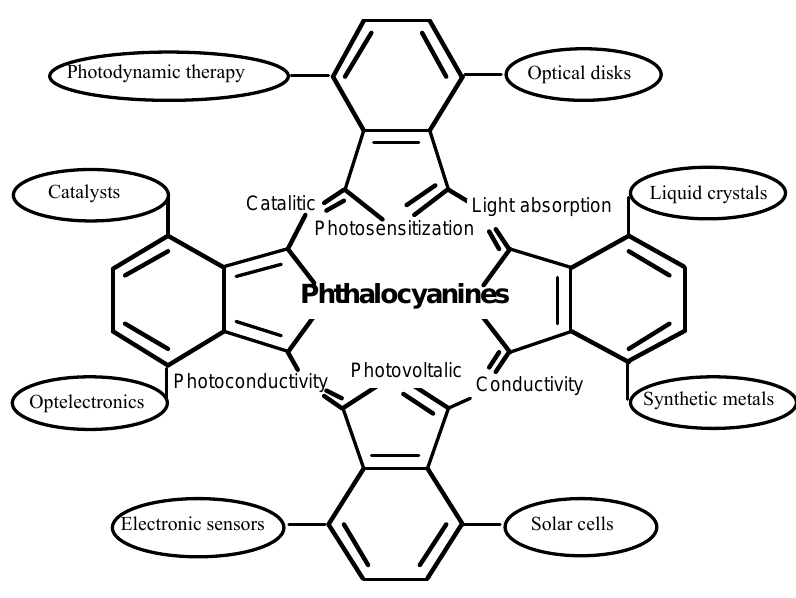
Figure 1. Typical function of phthalocyanine